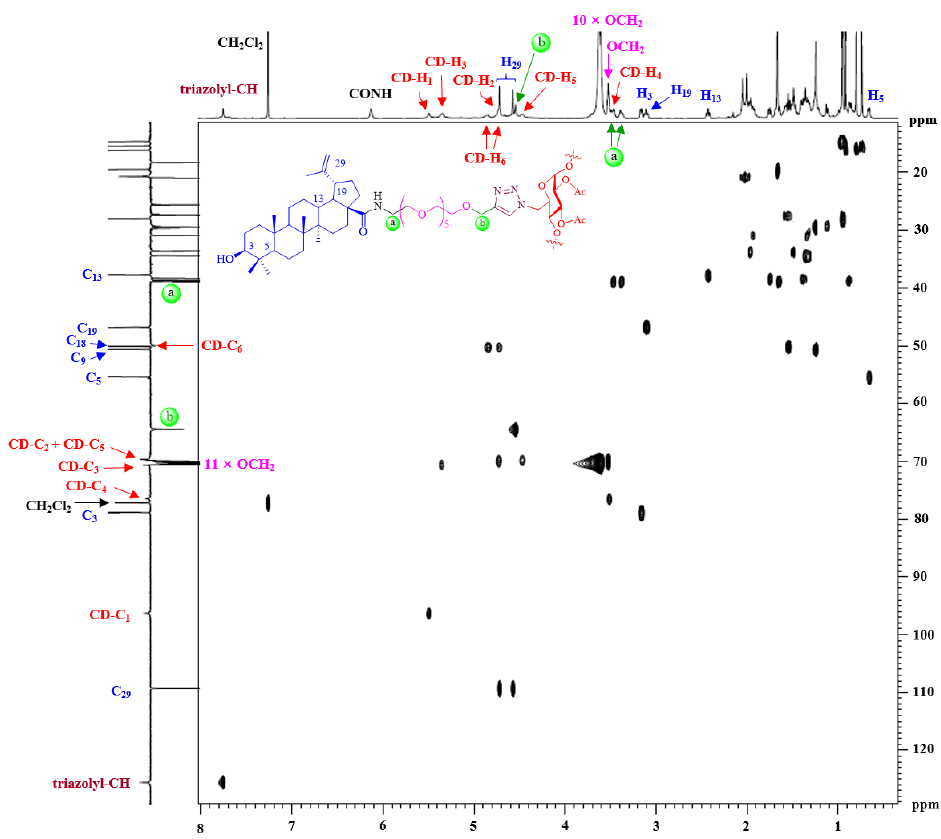
Figure 2. The 1 H- 13 C HSQC spectrum (600 MHz, 25 ◦ C, CDCl 3 ) of conjugate 64 demonstrates that it was a fully substituted heptavalent conjugate.